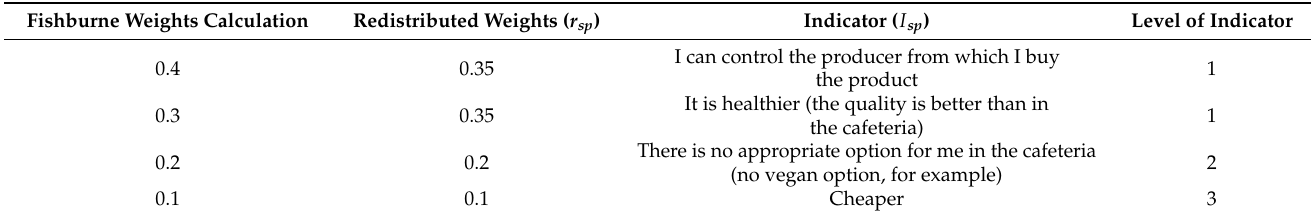
Table 2. Reasoning indicators for self-prepared food.